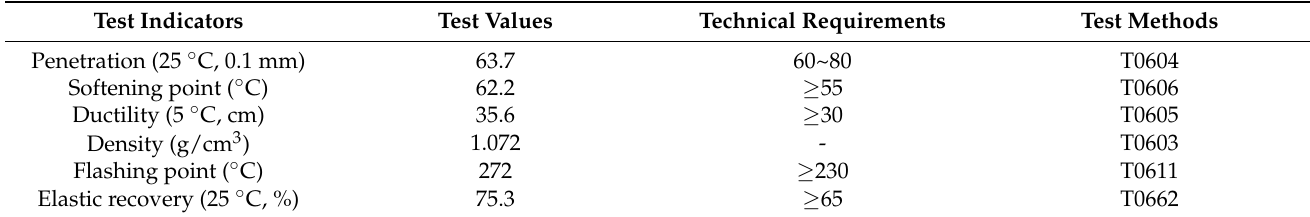
Table 1. Technical specifications of SBS modified asphalt.